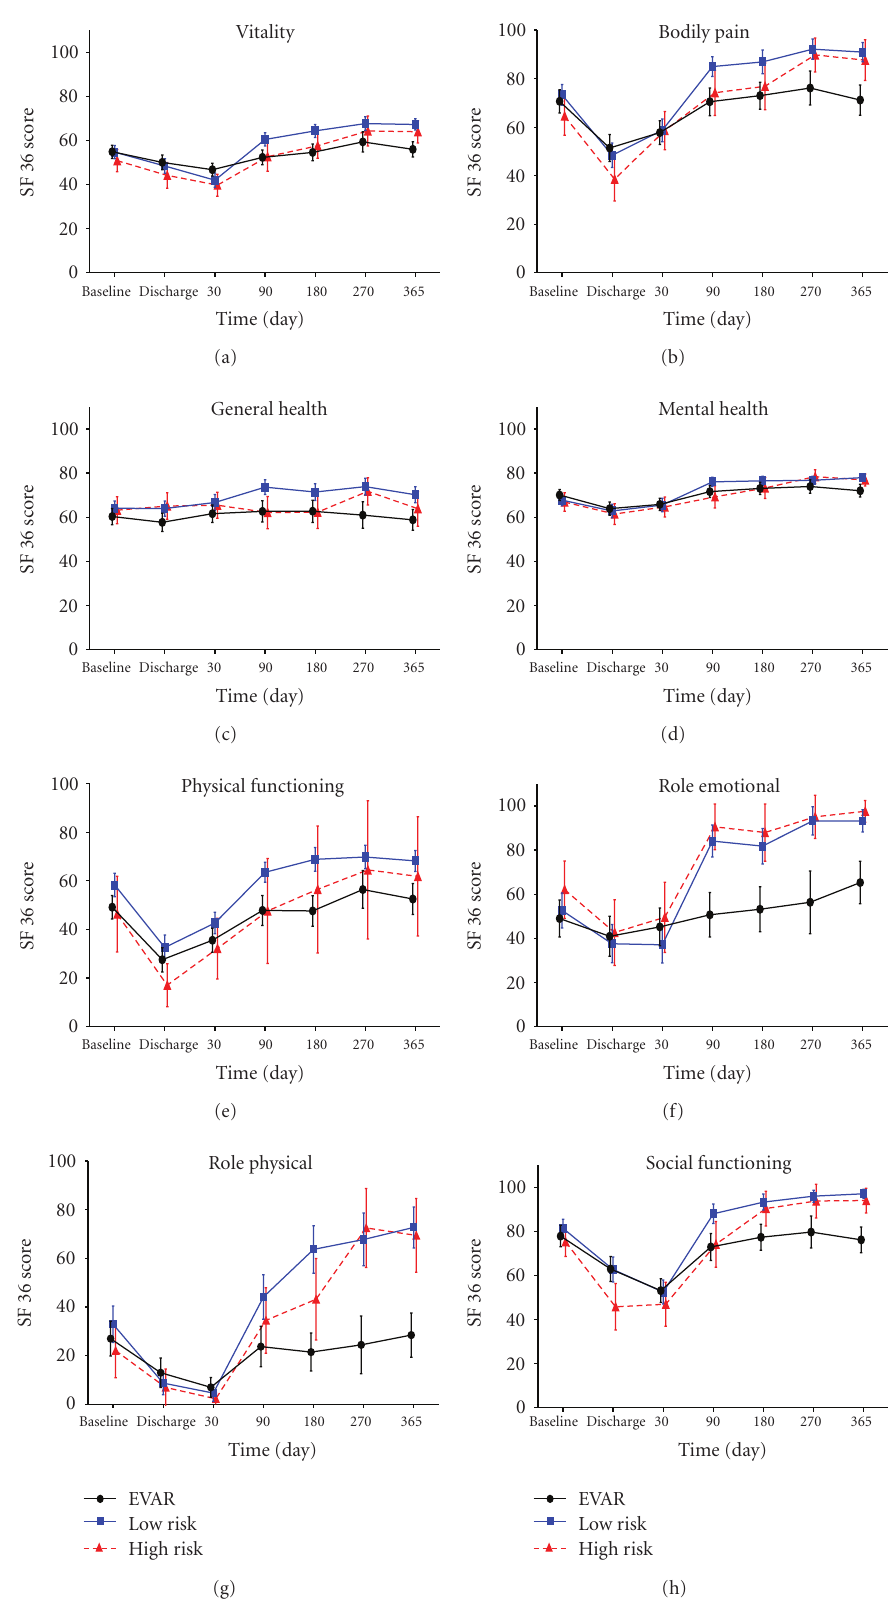
Figure 3: SF-36 domain scores and confidence